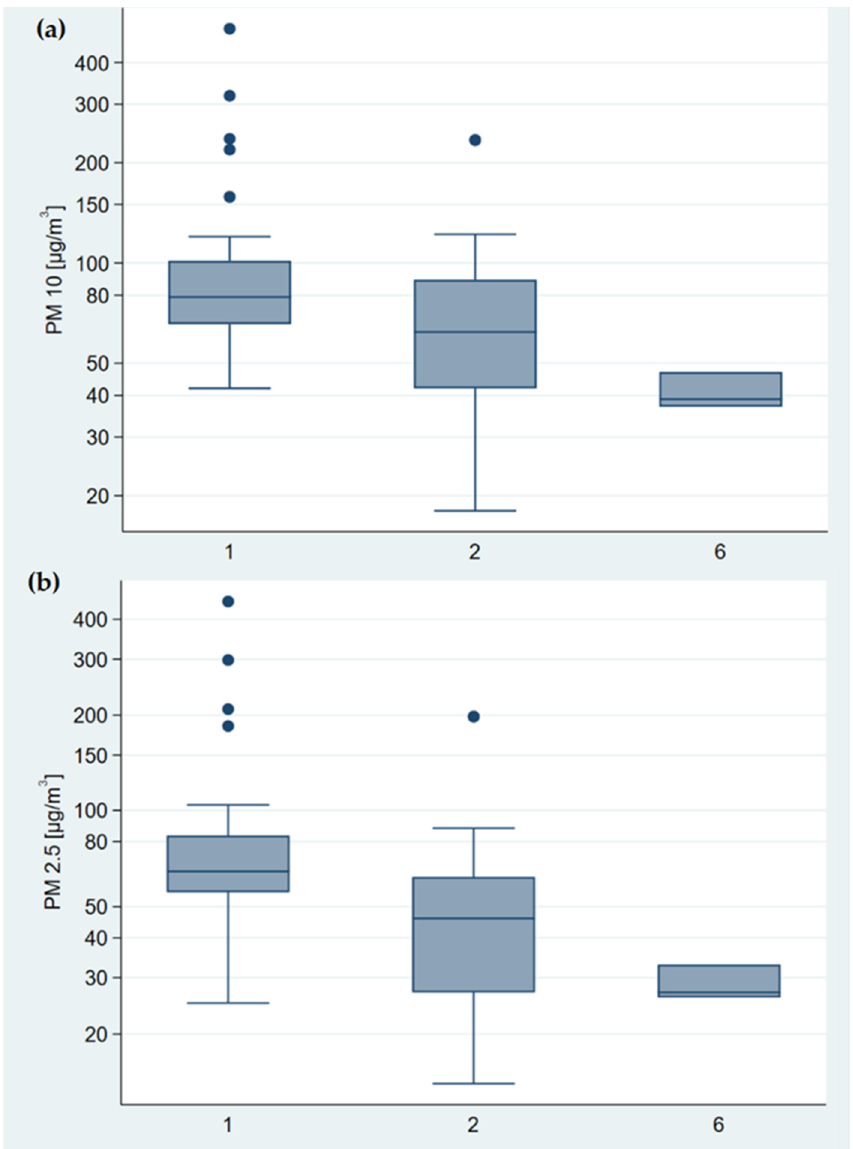
Figure 5. PM mass concentrations monitored in underground stations of three metro lines (l.1; l.2; l.6) deserving emblematic monuments within the French capital (using DustTrack device): ( a ) PM 10 mass concentration. ( b ) PM 2.5 mass concentration.